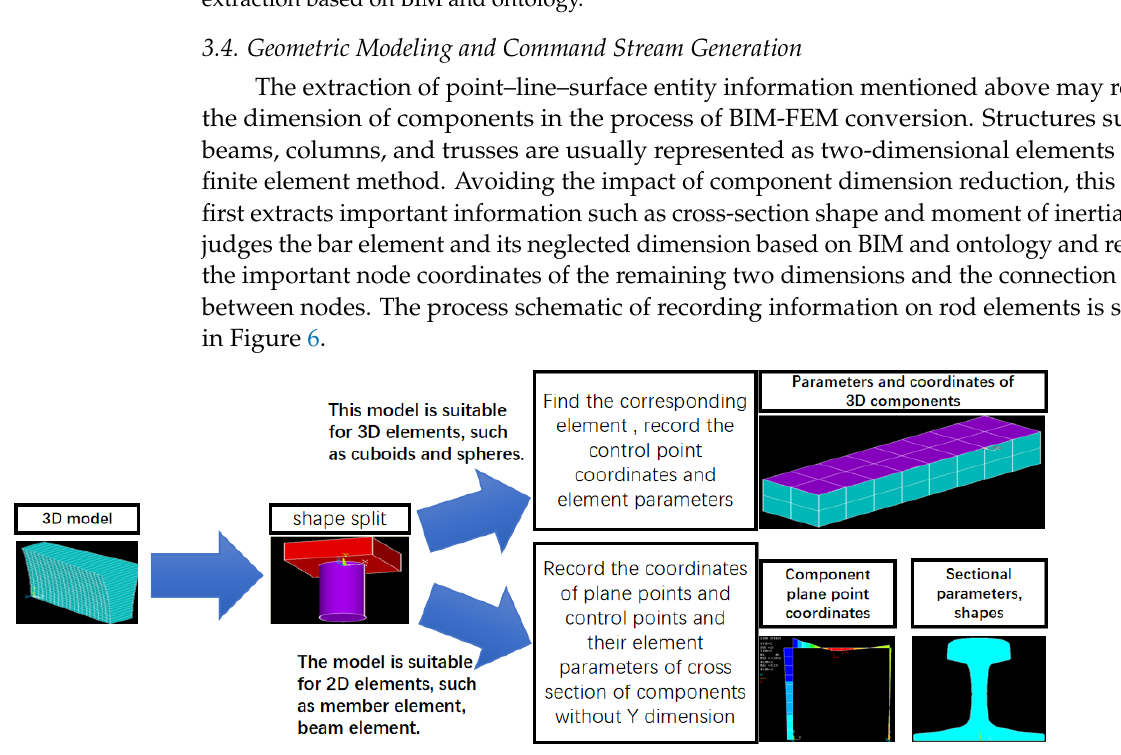
Figure 6. The process schematic of recording information of rod